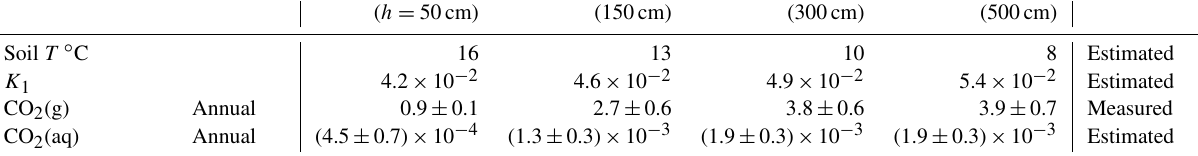
Table 2. Measured CO 2 (g) at different depths and corresponding estimated C CO Time Soil depth